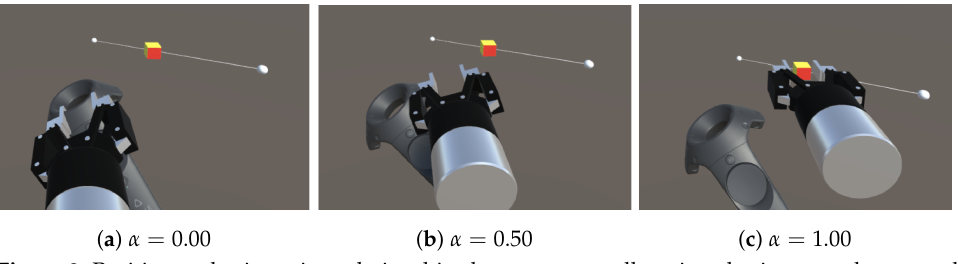
Figure 3. Position and orientation relationships between controller, virtual gripper, and target cube: ( a ) The gripper synchronizes with the controller. ( b ) The position and orientation of the gripper are between the controller and the target cube. ( c ) The gripper synchronizes with the target cube. In these figures, the controller model is shown for comparison but was not used during the